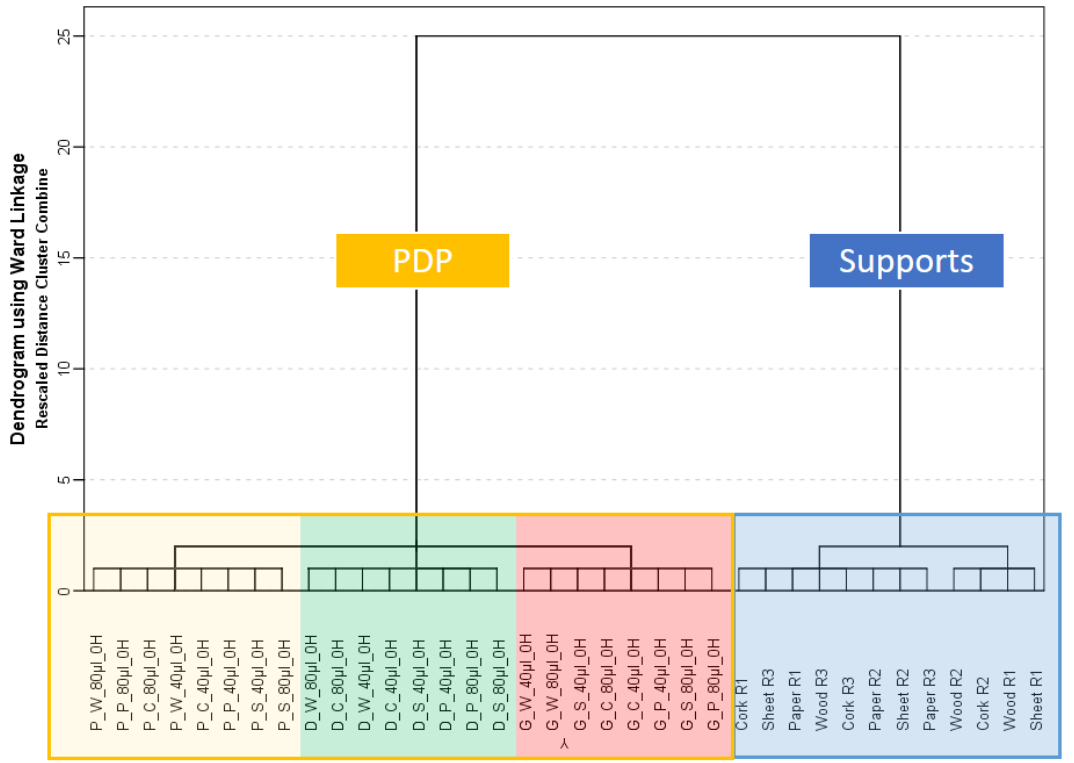
Figure 1. Dendrogram obtained in the hierarchical cluster analysis (HCA) using total ion mass spectrum (TIMS) for samples without weathering ( n = 60) with and without petroleum-derived products (PDPs).